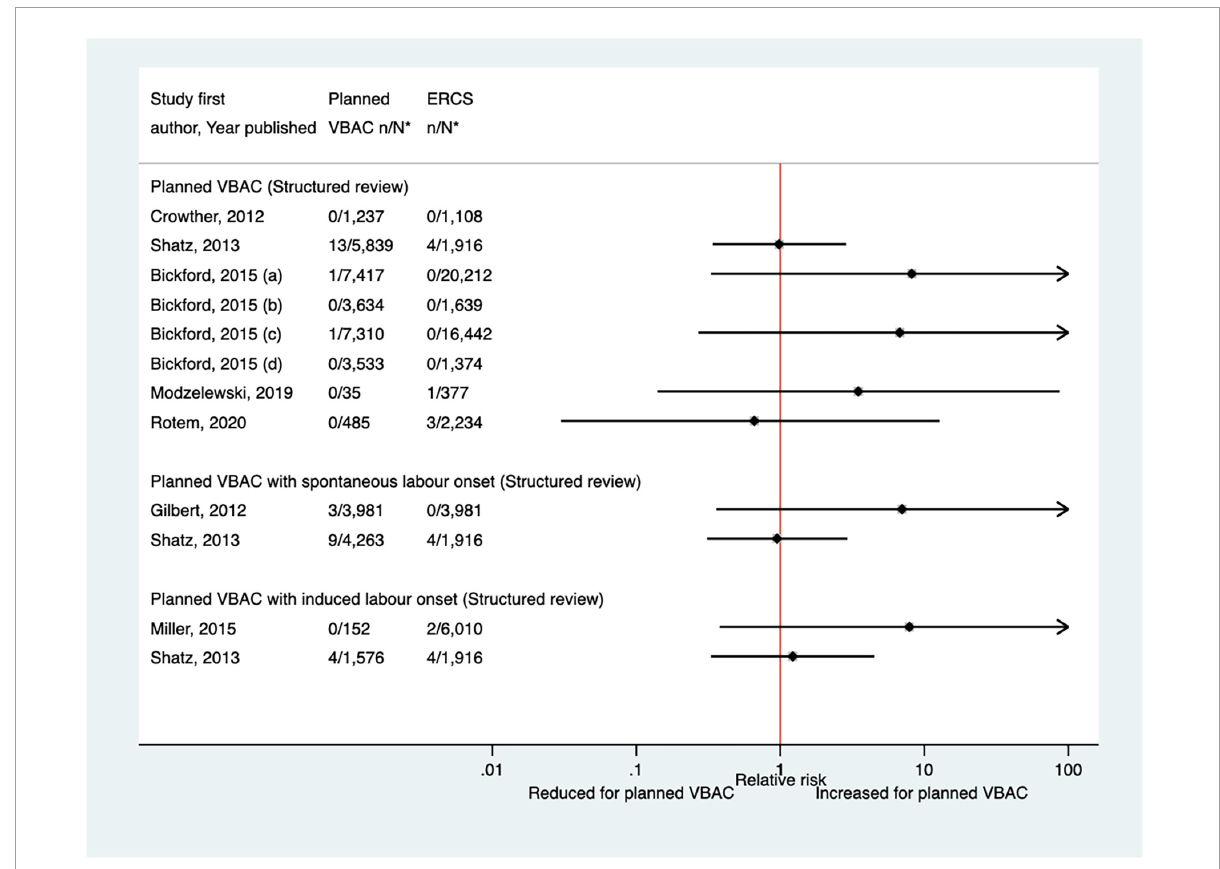
FIGURE10 Risk of hypoxic–ischemic encephalopathy/asphyxia for planned VBAC vs. ERCS. * n , number in group with the outcome; N , Total number in group. Bickford and Janssen (50) (a) risk in women with 1–2 prior CSs only, (b) risk in women with 1–2 prior CSs and ≥ 1 prior VB, (c) risk in women with 1 prior CS only, (d) risk in women with 1 prior CS and ≥ 1 prior VB. CS, cesarean section; ERCS, elective repeat cesarean section; VBAC, vaginal birth after previous cesarean; VB, vaginal